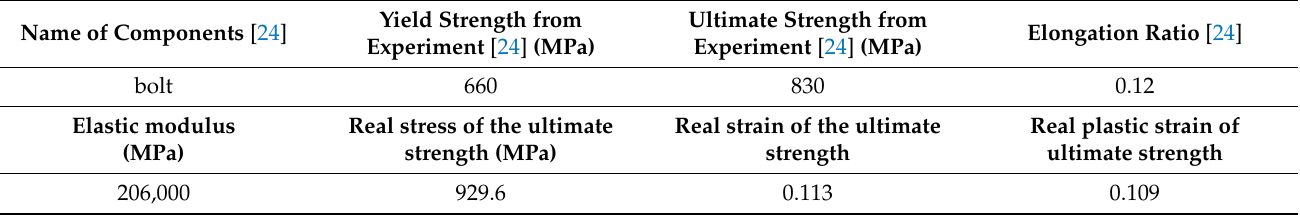
Table 2. Constitutive relationship of grade 8.8 high-strength bolt in FEM model for verification.